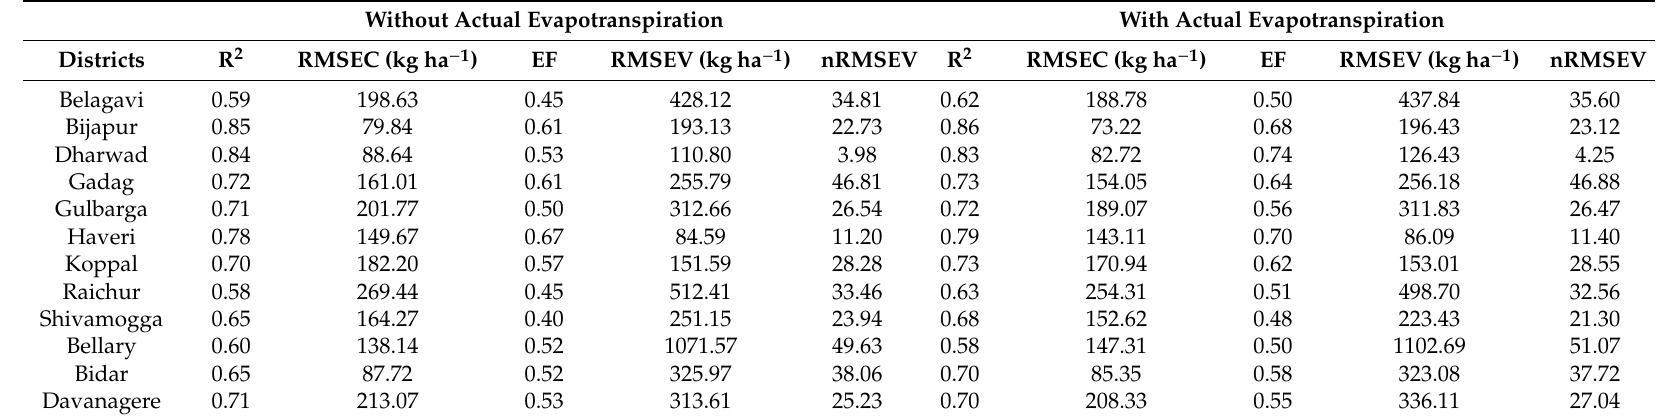
Table 8. Quantitative measures obtained for sorghum yield prediction of Karnataka using ridge regression.